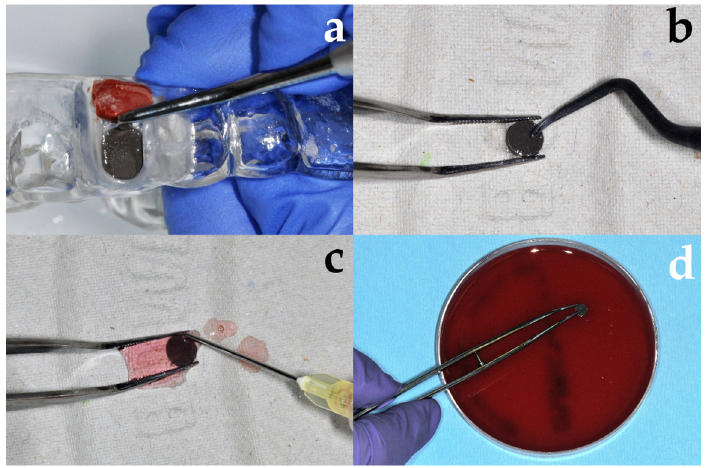
Figure 3. Chemo-mechanical debridement of Ti-Zr discs following biofilm formation. ( a ) Harvesting of the disc from the splint, ( b ) treatment with plastic curette, ( c ) rinsing with chlorhexidine, ( d ) samples repeatedly pressed with roughened and smooth surface on blood agar plate.